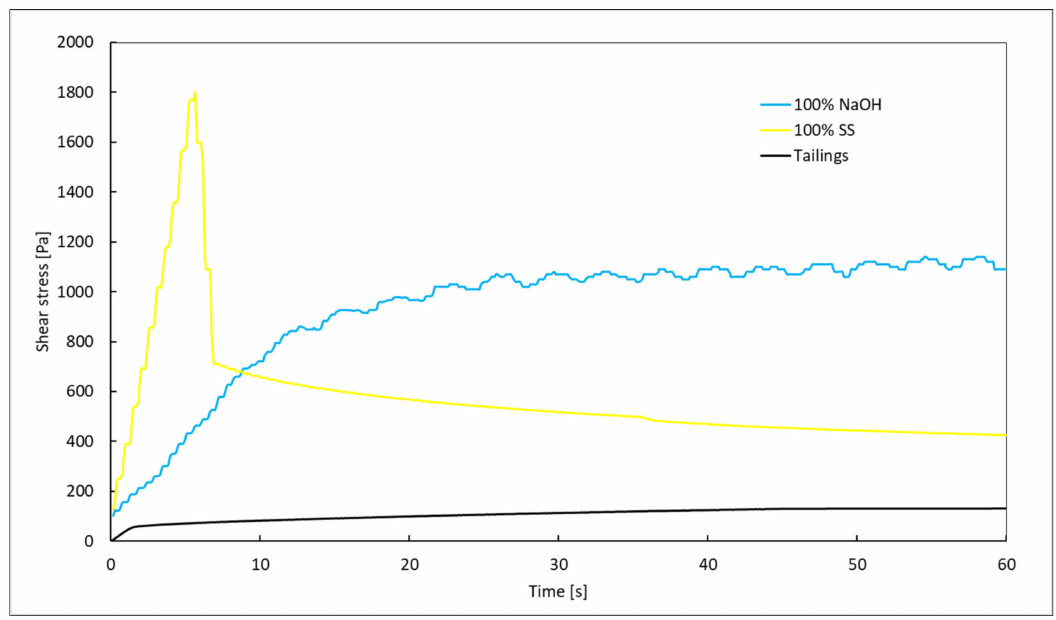
Figure 9. Rheological curves for fresh geopolymer